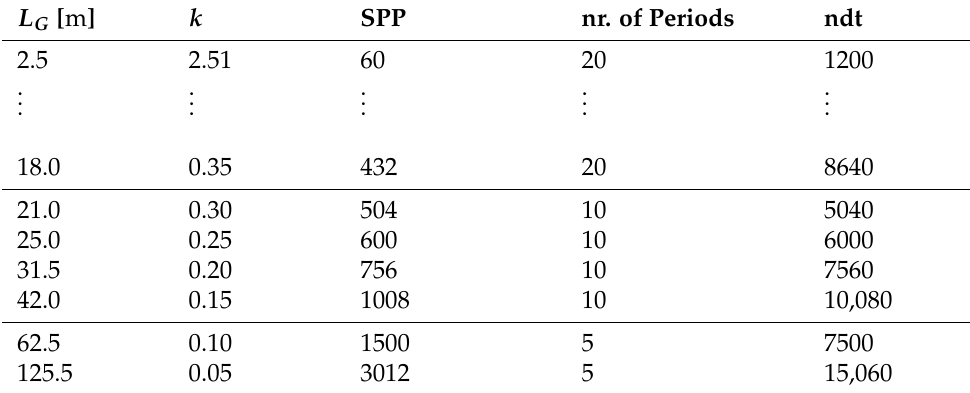
Table 2. Numerical settings for different gust lengths, independent of the Mach number (SPP: steps per period, ndt: total number of time steps).